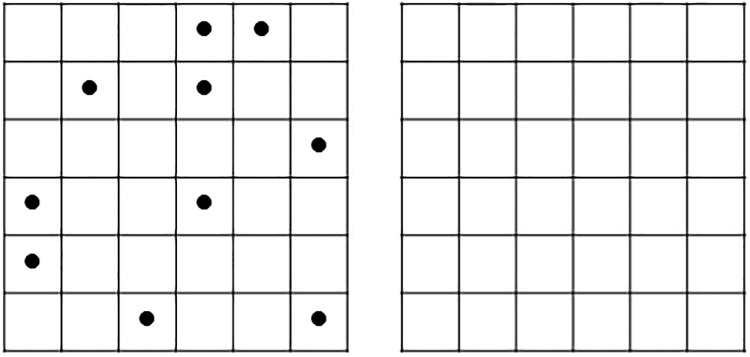
10/36 SRT.On the left side, the template lamina was presented for ten seconds followed by the blank one (right side). Participants were asked to remember the positions occupied by the dots. The original laminas size was 29 x 29 cm.